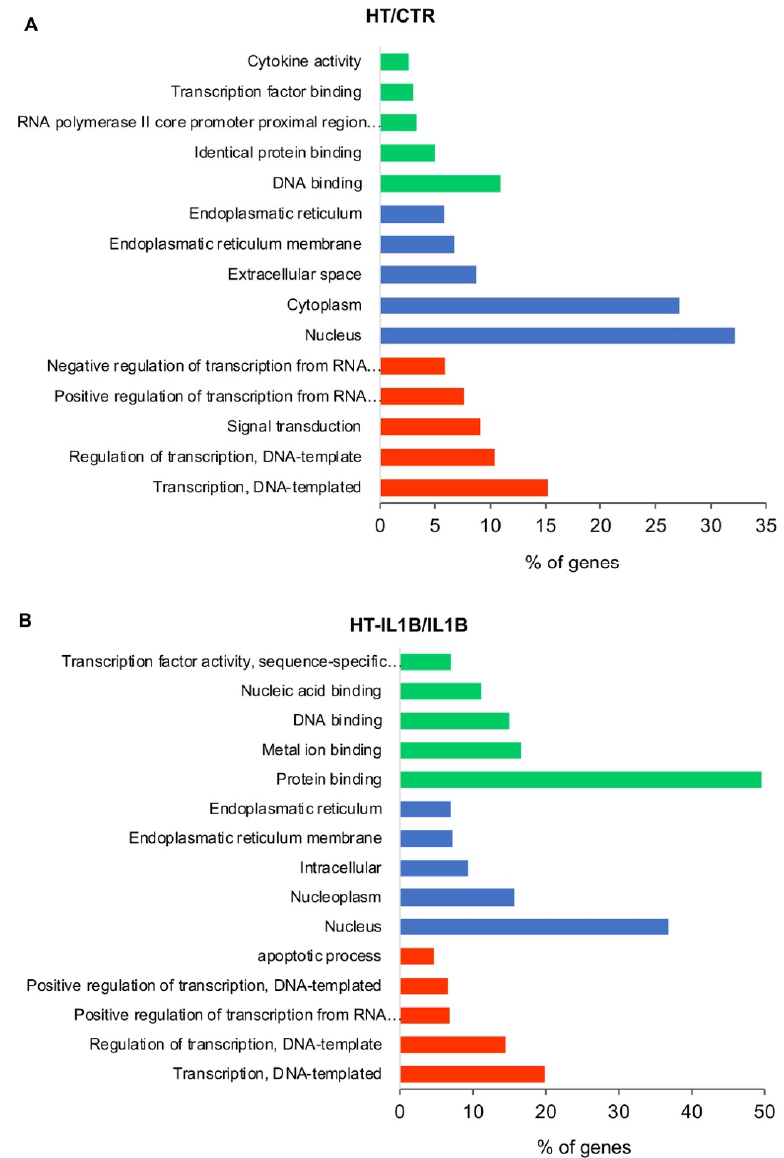
Figure 2. GO functional classification of the DEGs. The distributions are summarized in three main categories: biological process, molecular function, and cellular component. The x ‐ axis indicates the percentage of involved genes/total genes, and the y ‐ axis indicates the top five gene function sub ‐ classes in HT/CTR ( A ) and HT ‐ IL1B/IL1B ( B ).